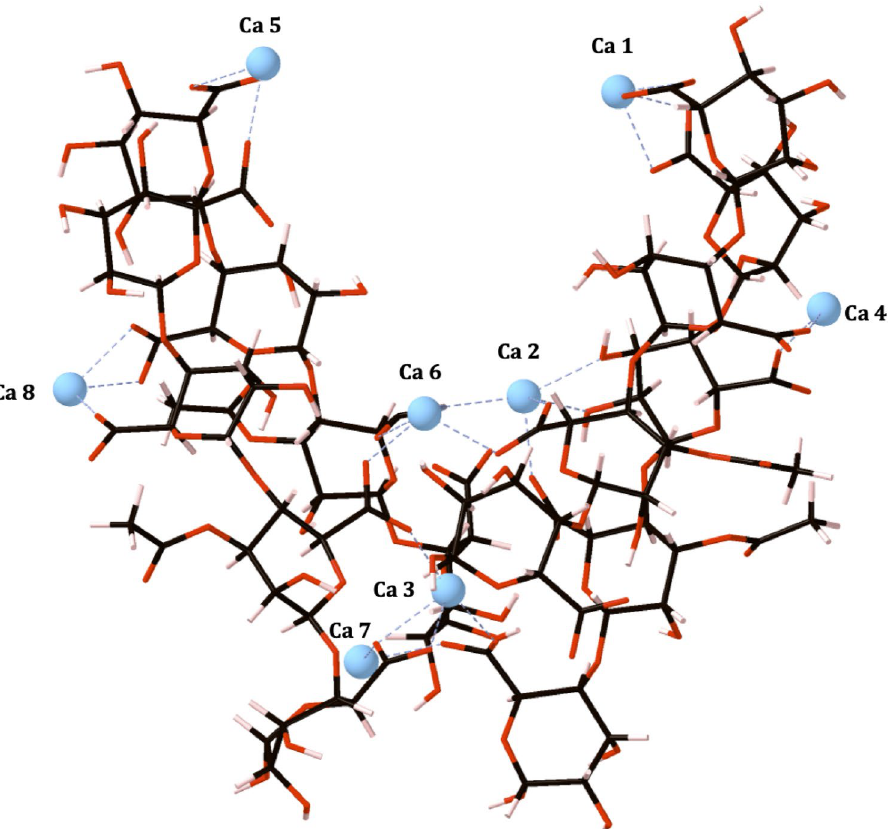
Figure 3. The 4-PolyMG MD structure, corresponding to the structure of the hydrated mucoid P. aeruginosa EPS at physiological temperature. Carbon atoms are shown in grey, oxygen in red, calcium in blue and hydrogen in pink. Calcium ions are labelled and calcium–oxygen ionic bonds are shown with dashed blue lines. Explicit water molecules are not